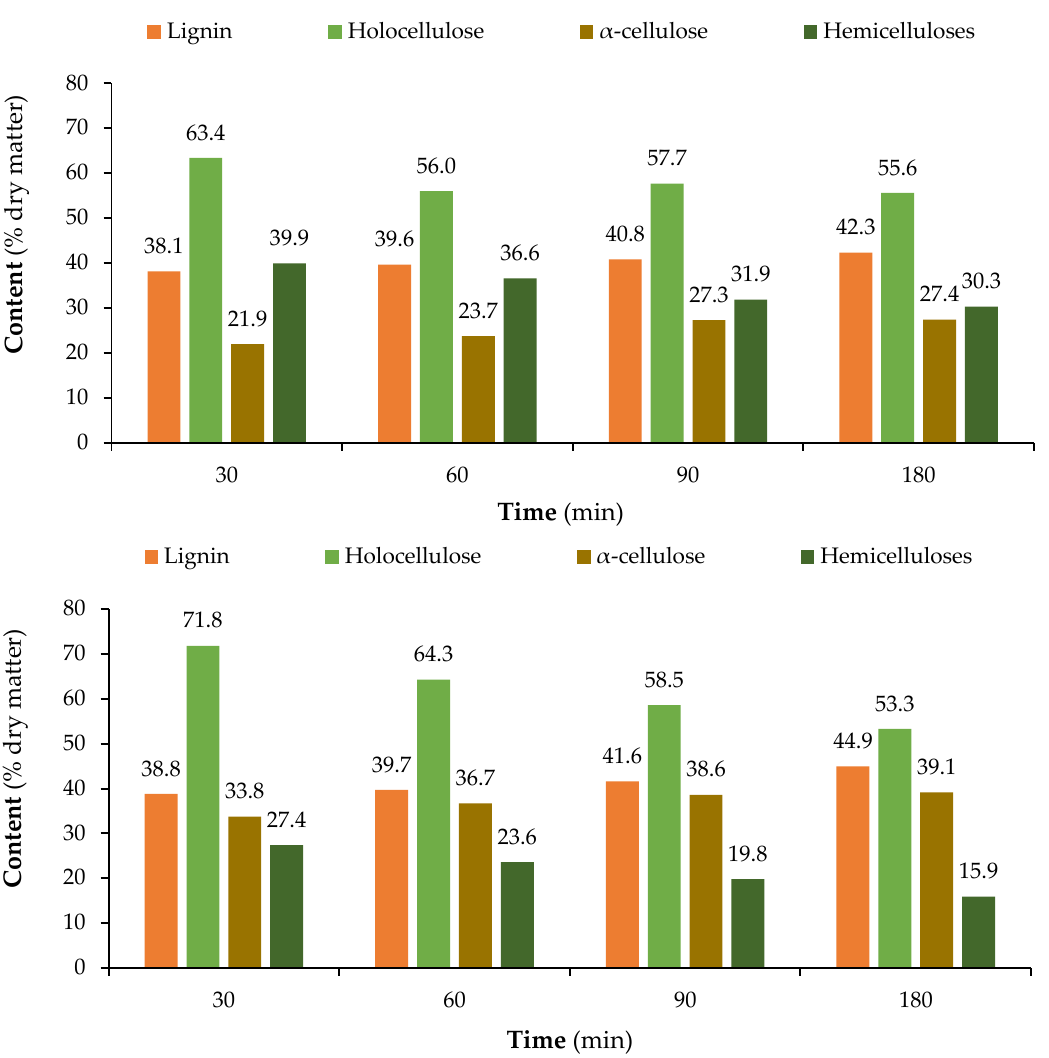
Figure 3. Variation in the chemical composition of the hydrolysed SCS with time at 160 °C ( top ) and 170 °C ( bottom ).